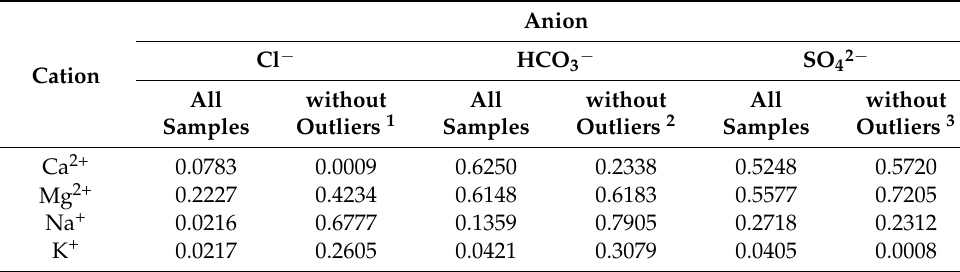
Table 3. Determination coefficients between the concentrations (mEq L − 1 ) of the major ions in the water samples collected from Clos ani Cave. ,